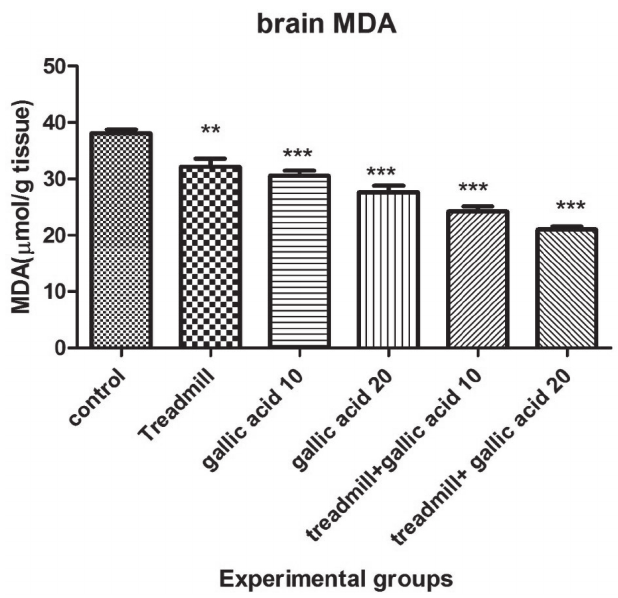
FIGURE 5 - The effects of gallic acid and physical exercise, alone and combined, on brain antioxidant level; ** = ( p <0.01); *** = ( p